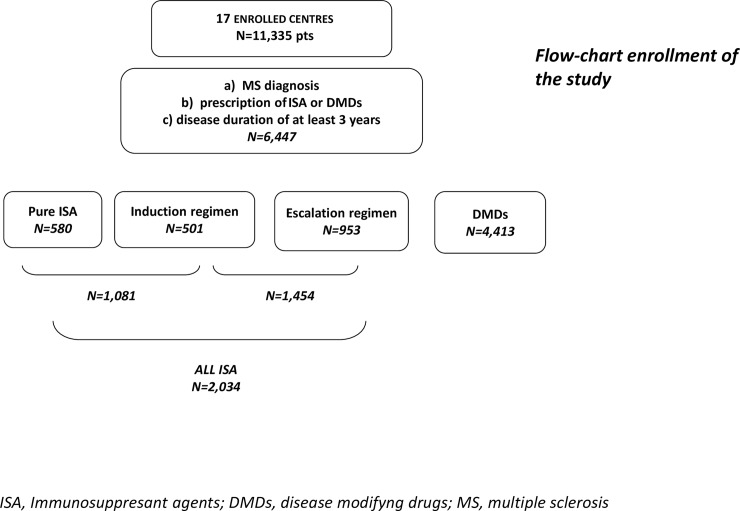
Shows the distribution of ISA subgroups in our cohort.